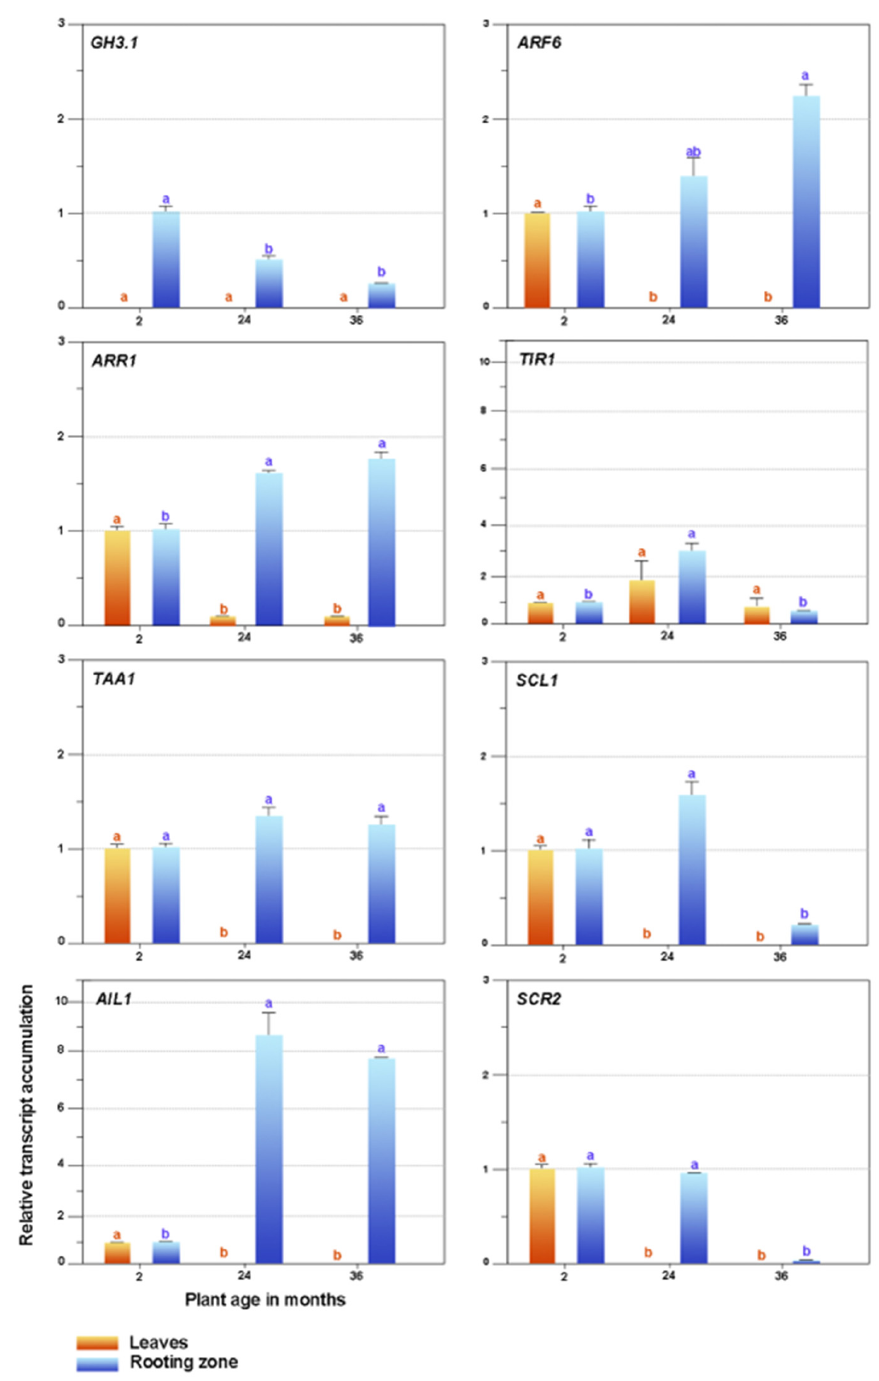
Figure 7. Expression patterns of candidate genes related to plant ageing and rooting competence. GH3 ‐ 1 , Gretchen Hagen3 ; ARF6 , auxin response factor ; ARR1 , Arabidopsis response regulator 1 ; TIR1 ,